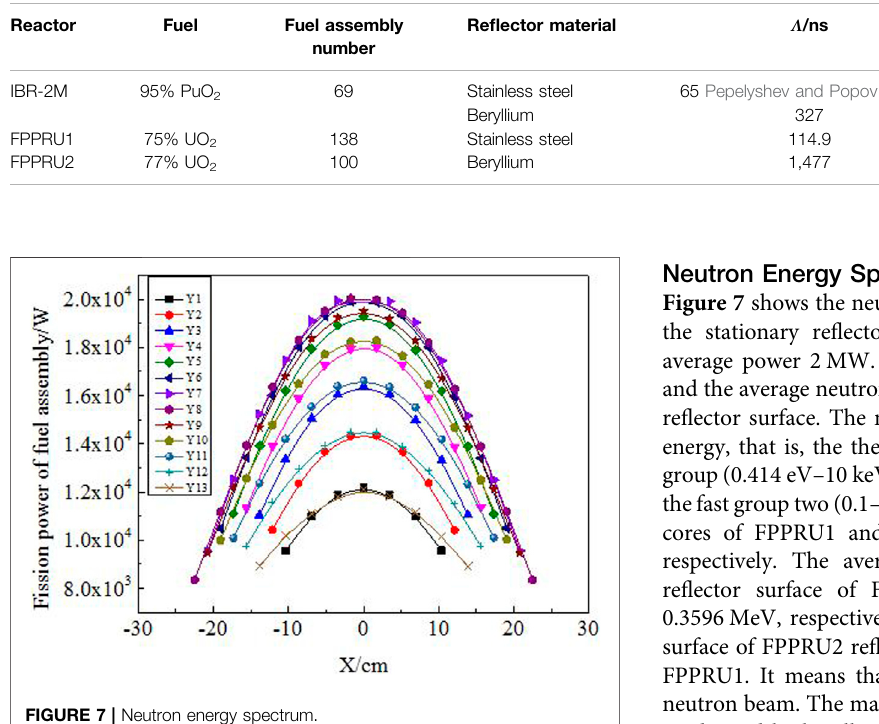
FIGURE 7 | Neutron energy